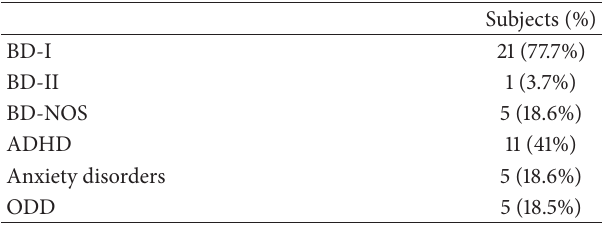
Table 2: Diagnostic data ( 𝑛 = 27 ).